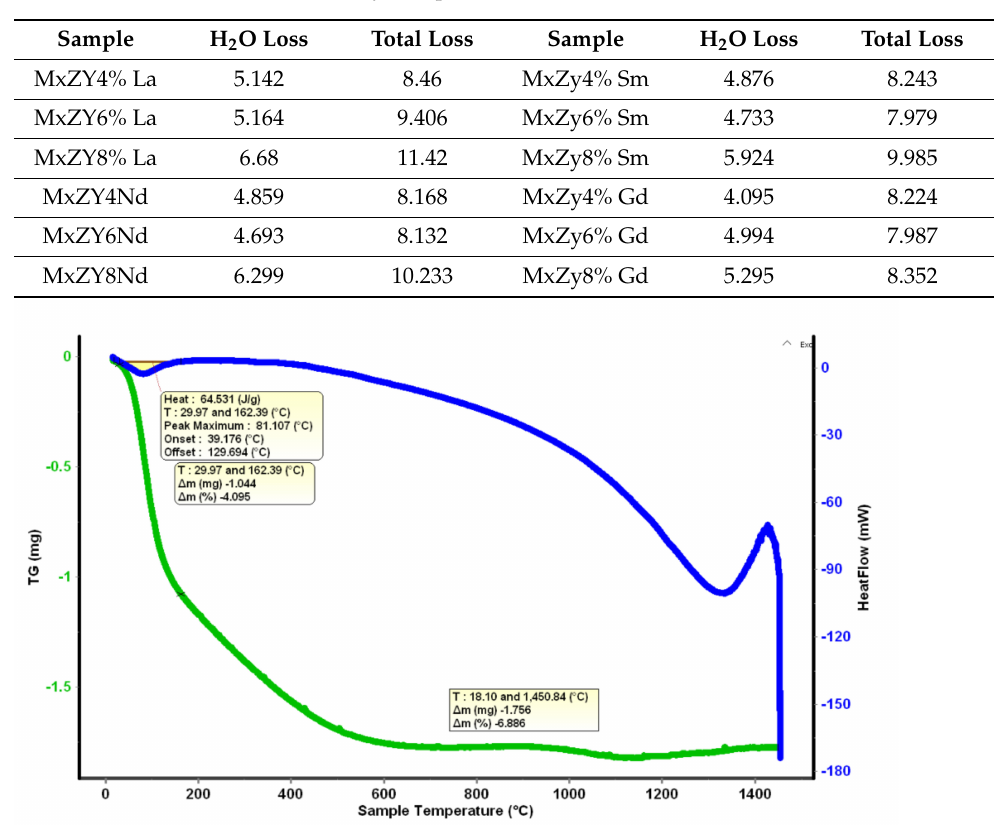
Table 4. Mass losses (wt.%) for MxZy%Ln powders.